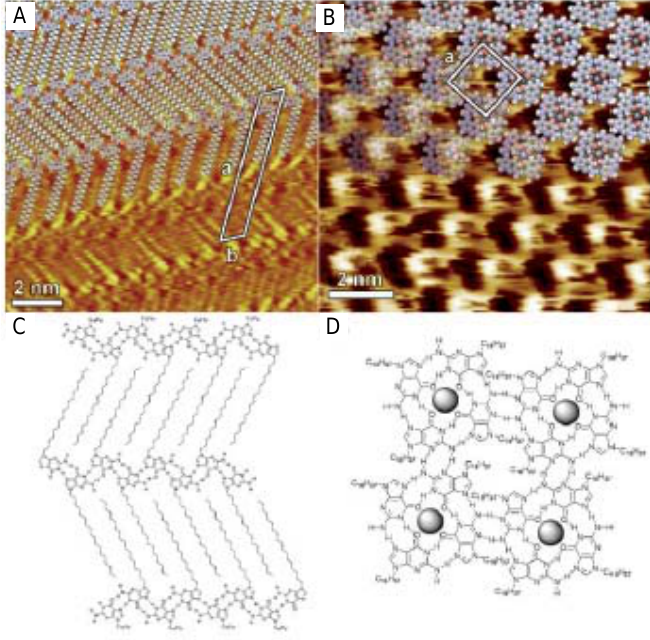
Figure 11. STM images (A and B) and tentative models (C and D) of self-assembled structures of guanines. Without (A and C) and with (B and D) potassium. Reproduced with permission from reference [45]. Copyright Wiley-VCH Verlag GmbH & Co.